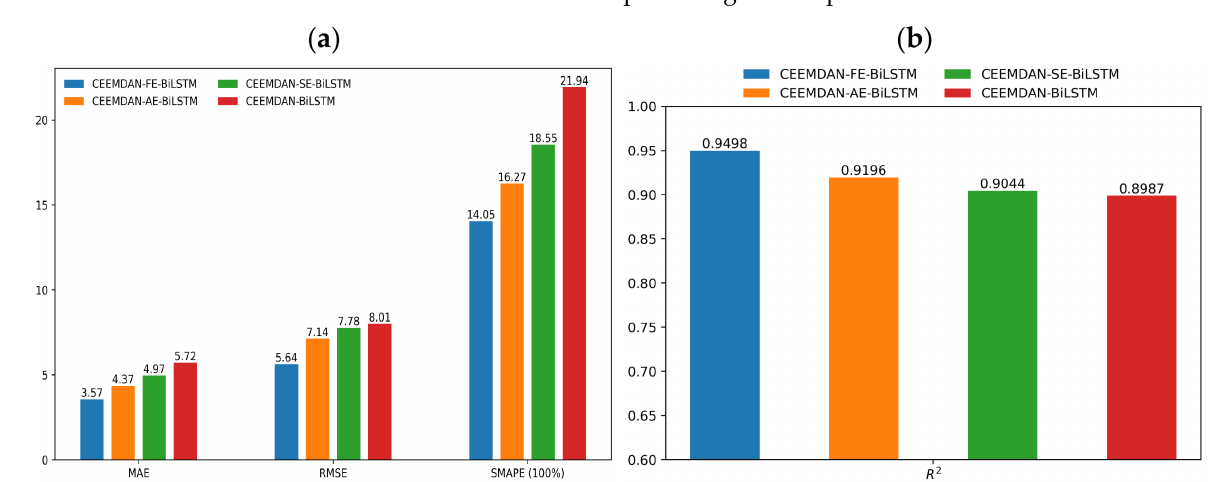
Figure 9. Comparison of PM 10 concentration prediction model: ( a ) horizontal error; ( b ) goodness of fit.